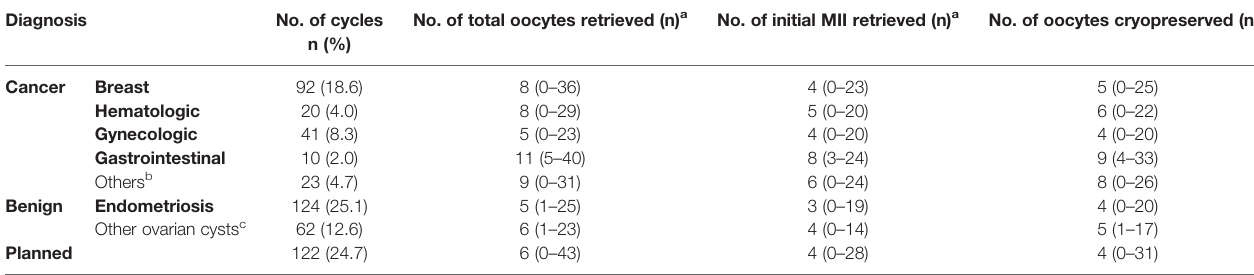
TABLE 1B | The outcomes of the controlled ovarian stimulation cycles of oocyte cryopreservation (494 cycles). Diagnosis No. of cycles